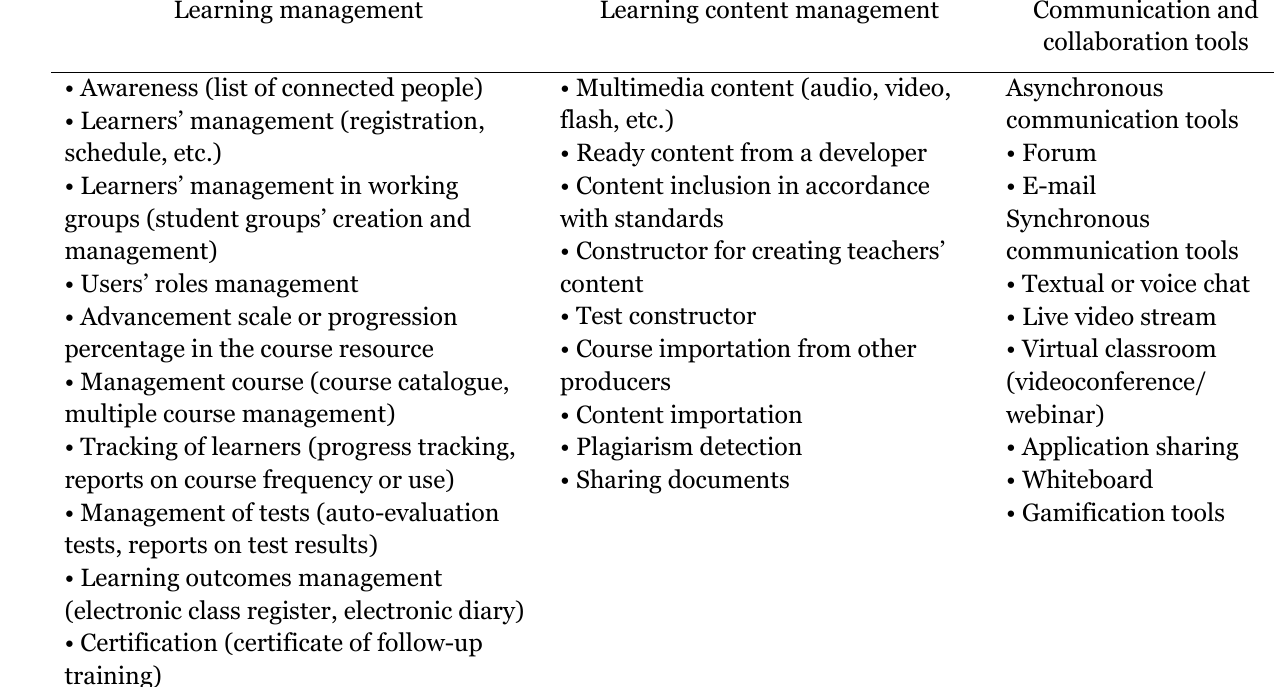
Criteria of Evaluating E-Learning Platforms’ Functionality Learning management